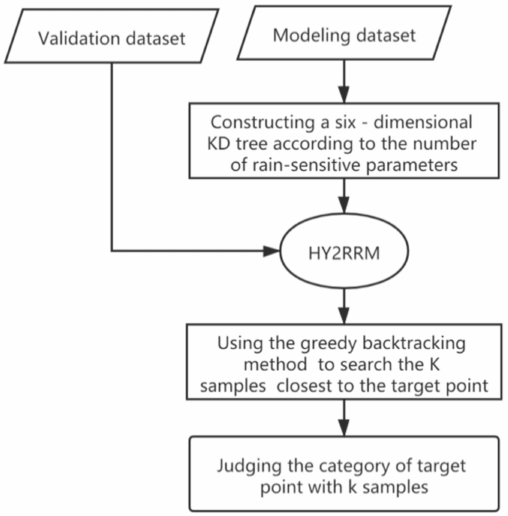
Figure 3. Technology flow of the KNN